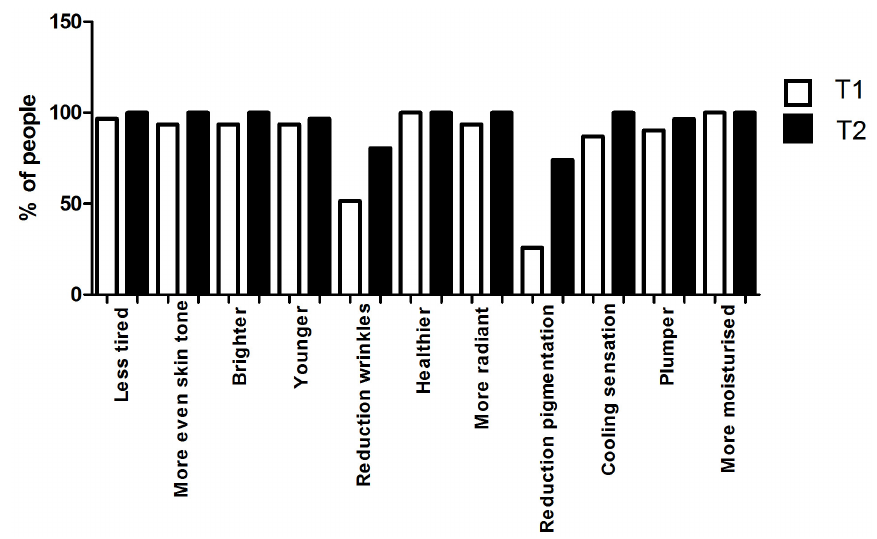
Figure 8. Self-Perception Questionnaire responses of clinical trial subjects after one application (T1) and after 4 applications (T2) of the test product.